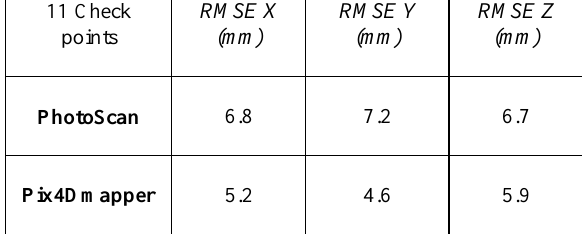
Table 2. RMSE estimated on set of 11 check